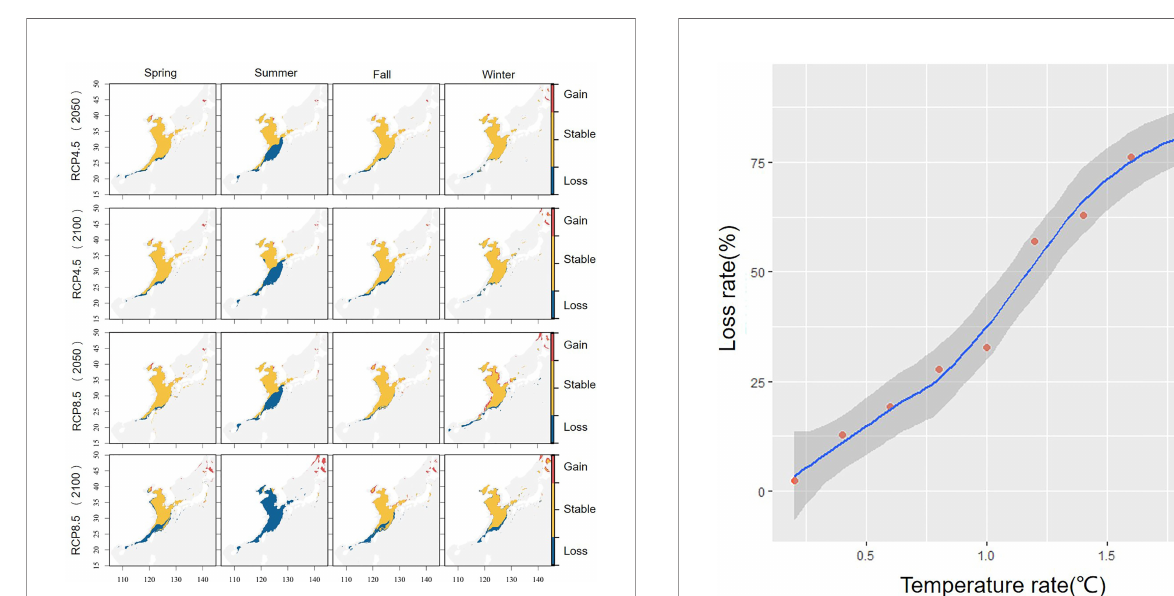
FIGURE 6 | Reduction index of suitable habitat for Scomberomorus niphonius under uniform